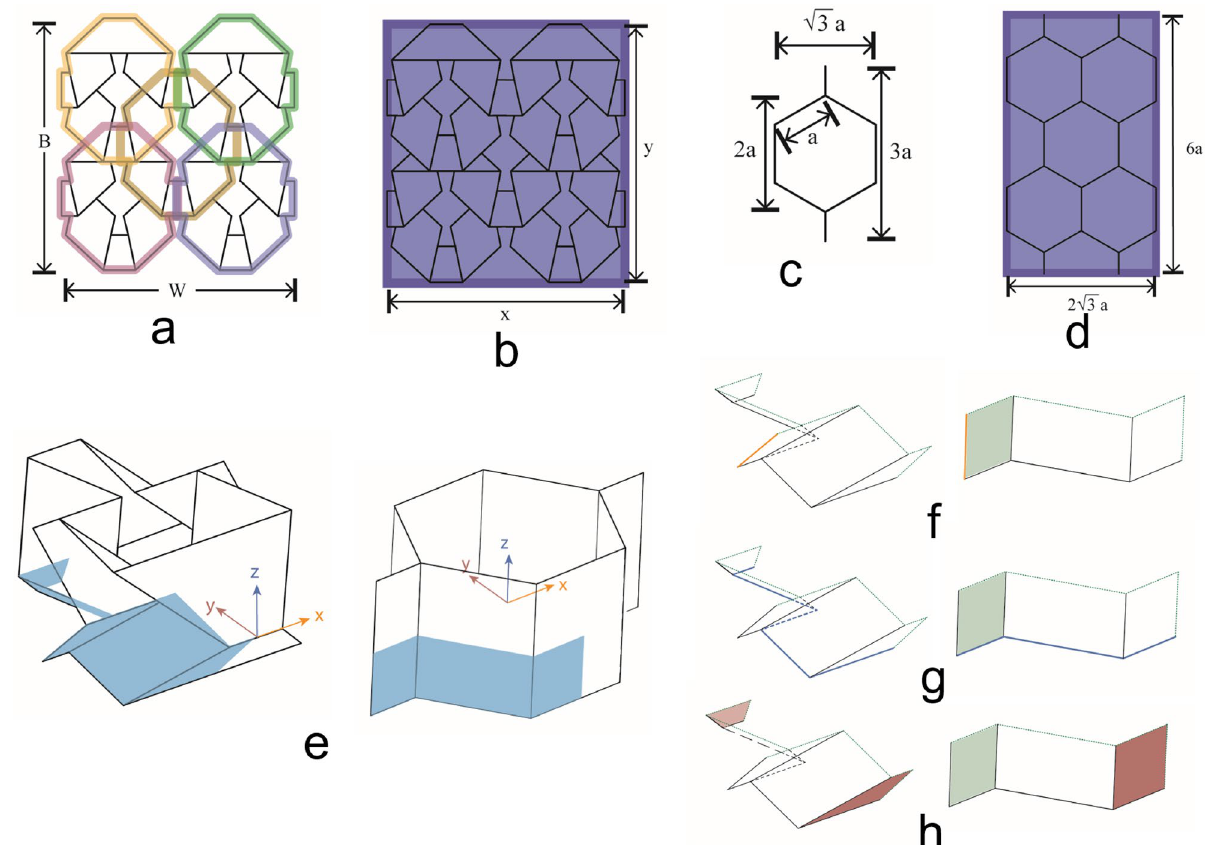
2 TMP array. Each color shows the outline of a different TMP unit cell. ( b ) The rectangular Figure 6. ( a ) A 2 × area that the 5 TMP array occupies is shown by the blue box. ( c ) The parameters of a regular hexagonal honeycomb unit cell. a is the side length of the hexagon. All other dimensions are defined in relation to this parameter. ( d ) The area that the 5 hexagon array occupies is shown by the blue box. The width and height dimensions of the box are shown in terms of the sidelength, a , of the hexagon. ( e ) The principal directions used for the mechanical analysis of the TMP and Hexagonal Honeycomb. The origin of the TMP is located at the center of the front crease. The origin of the hexagonal honeycomb is located at the center of the hexagonal honeycomb. Subfigures ( f )–( h ) show the loading conditions on 1 4 of the TMP and 1 8 of the hexagonal honeycomb. ( f ) The loading conditions in the x -direction. The deflection was applied on the orange edge in the positive x -direction. ( g ) The loading conditions in the y -direction. The deflection was applied on the front face in the positive y -direction. A rigid support was placed on the back face, shown in lighter red. ( h ) The loading conditions in the z -direction. The deflection was applied on the bottom edge, shown in blue, in the positive z -direction. The green dashed lines show where the frictionless supports were applied to each honeycomb structure. The lighter green area shows a frictionless support on the opposite side to the panel Comparison of TMP and hexagonal honeycomb arrays. As discussed in “TMP homogenization method” sec- tion hexagonal honeycomb arrays have been used for the design of electromagnetic absorbers. A regular (equi- lateral and equi-angular) hexagonal honeycomb array is compared here with our TMP array. Notably, a regular (equilateral and equi-angular) hexagon is the most common hexagonal honeycomb used. However, a regular hexagon does not exactly match the shape of our TMP, as illustrated in Fig. 6 (also see Supplementary Fig. S7). A regular hexagonal honeycomb has an aspect ratio of √ 3 . The aspect ratio of the TMP depends on the desired fold angle in addition to the lengths of the panels. The equation for the aspect ratio (AR) of the TMP is: